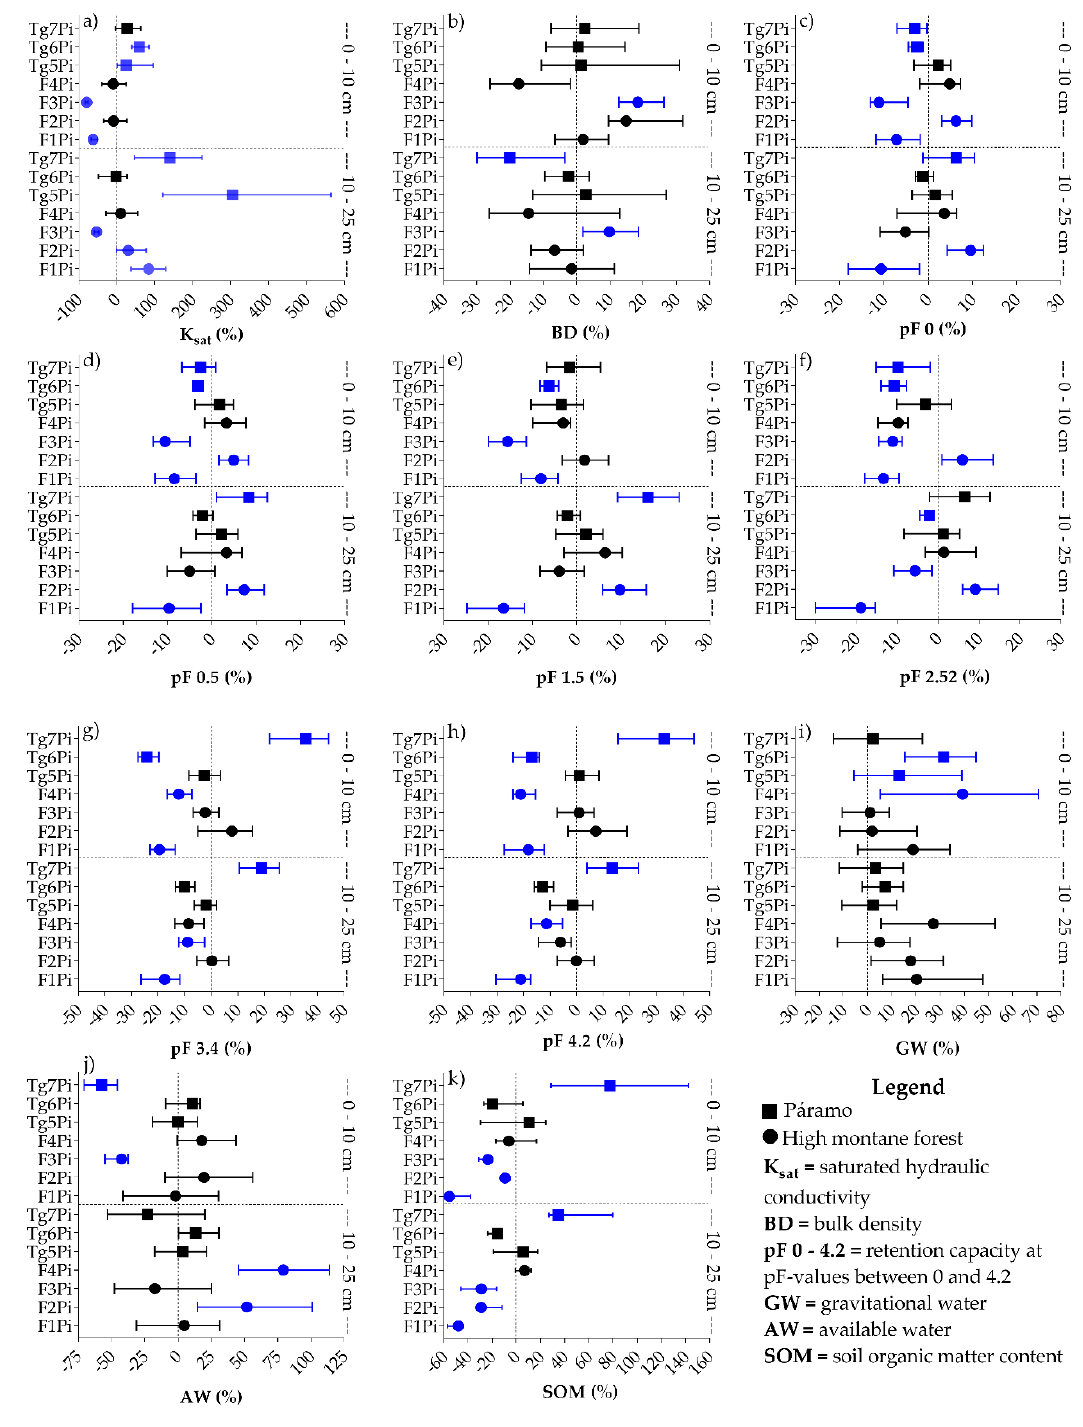
Figure 2. Forest and p á ramo plots showing the percentage change in hydro-physical properties and SOM content (increase or decrease) of the soils’ surface horizons (0–10 and 10–25 cm) due to pine afforestation. Site codes: FPi = pine plantation in the high montane forest; TgPi = pine plantation in p á ramo. Blue-colored lines represent a significant change ( p < 0.05) and black-colored lines represent a non-significant change ( p > 0.05) in the variable.